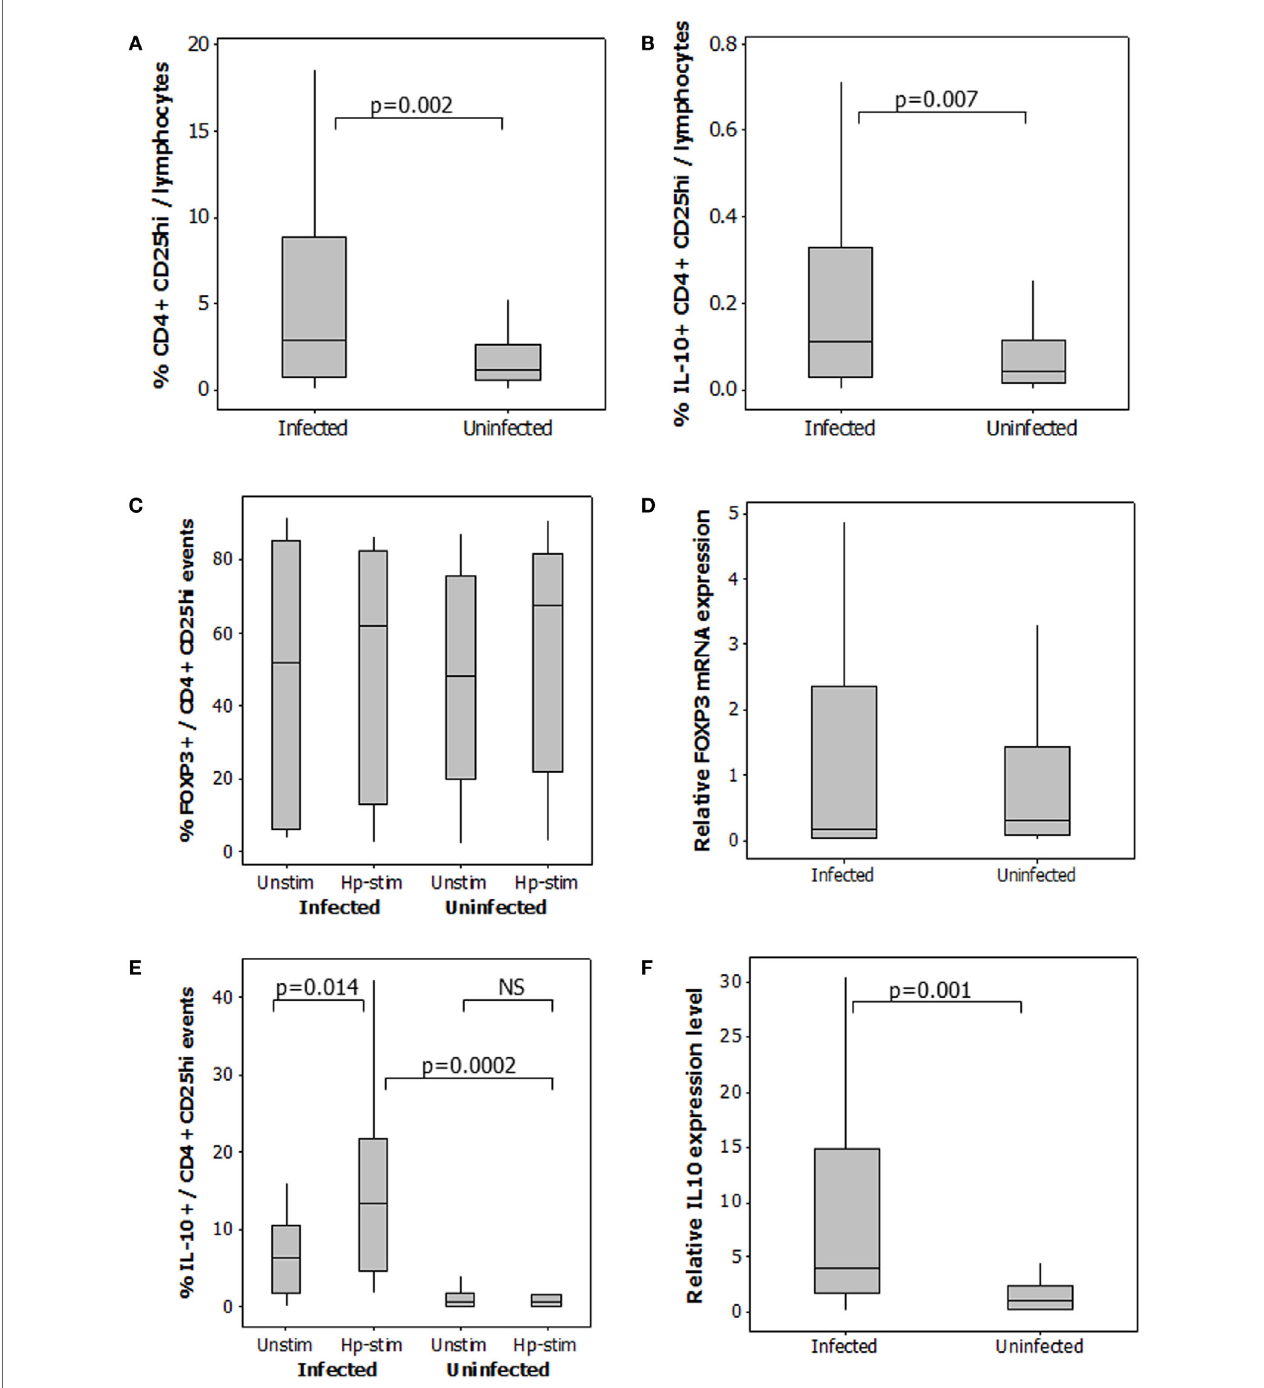
FigUre 3 | regulatory T-cells in the peripheral blood of 49 H. pylori - i nfected and 58 uninfected patients . The percentage of CD4 + CD25hi events among gated lymphocytes (a) . For determination of IL-10 + CD4 + CD25 hi Tregs (B) , PBMCs were cultured in the presence and absence of Hp lysate antigen. Median frequencies of IL-10 + CD4 + CD25 hi events among unstimulated cells were 0.04% (uninfected donors) and 0.04% (infected donors). The proportion of CD4 + CD25 hi cells expressing FOXP3 (c) and IL-10 (e) was assessed in PBMCs cultured with and without Hp lysate antigen (Unstim and Hp-stim, respectively). RT-PCR was performed on freshly isolated PBMCs from 48 infected and 26 uninfected patients to quantify FOXP3 (D) and IL10 (F) mRNA expression levels. Data were normalized relative to GAPDH expression. NS = no significant